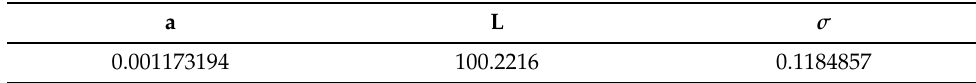
Table 6. Estimates of IGBM model on energy-switching data.